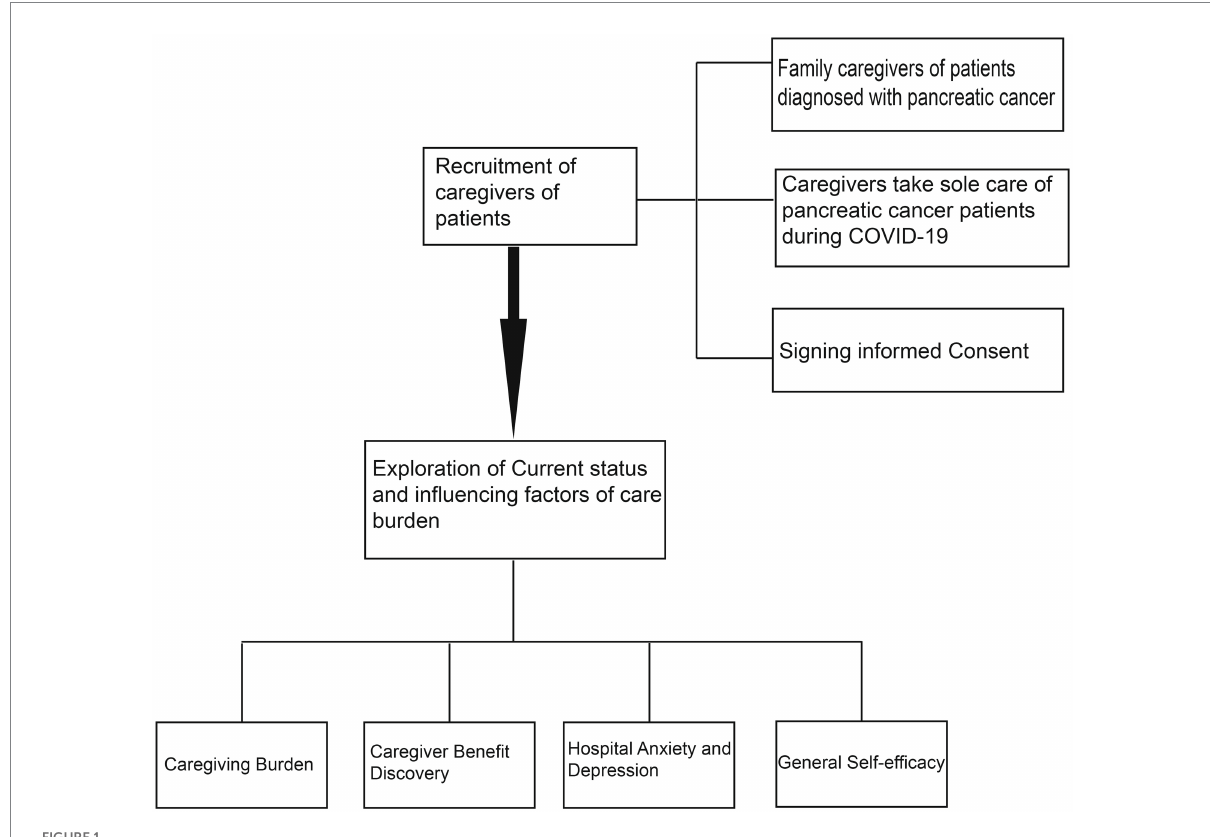
FIGURE 1 The flow